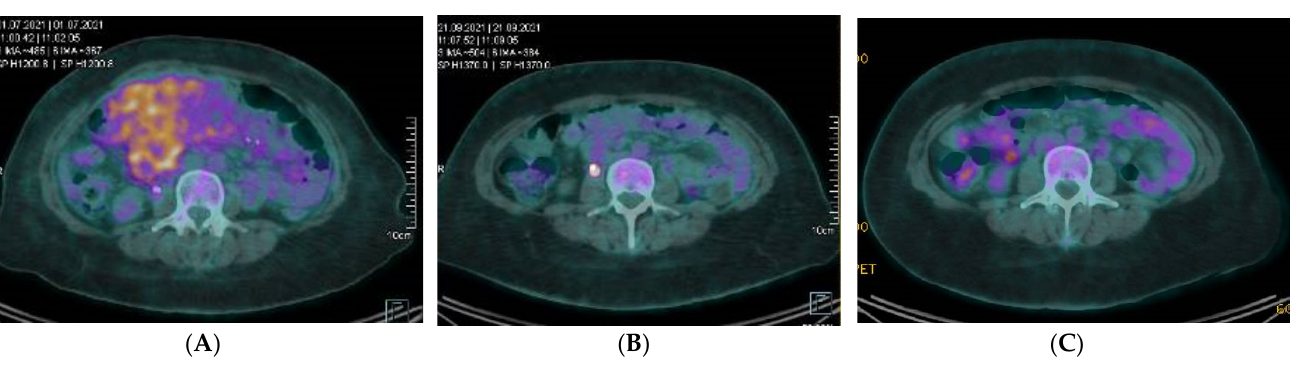
Figure 4. Positron emission tomography (PET) scans showing evolution in time of the abdominal EIMS with large hypermetabolic mesenteric mass, associated with several hypermetabolic intraperitoneal nodules ( A ) A clear morpho-metabolic regression of the mesenteric mass and secondary intraperitoneal implants previously visualized 3 and 6 months after targeted therapy with alectinib ( B , C ). ( A ) Baseline. ( B ) After 3 months of alectinib. ( C ) After 6 months of alectinib. In the study by Lee et al. [70], RRBP1-ALK fusion oncoprotein was found in three cases of EIMS, with ALK expression predominantly cytoplasmic with peri-nuclear accentuation. Note that RRBP1-ALK expression was not found by the authors in 100 cases of ALK-positive lung adenocarcinoma, anaplastic large-cell lymphomas, epithelioid fibrous